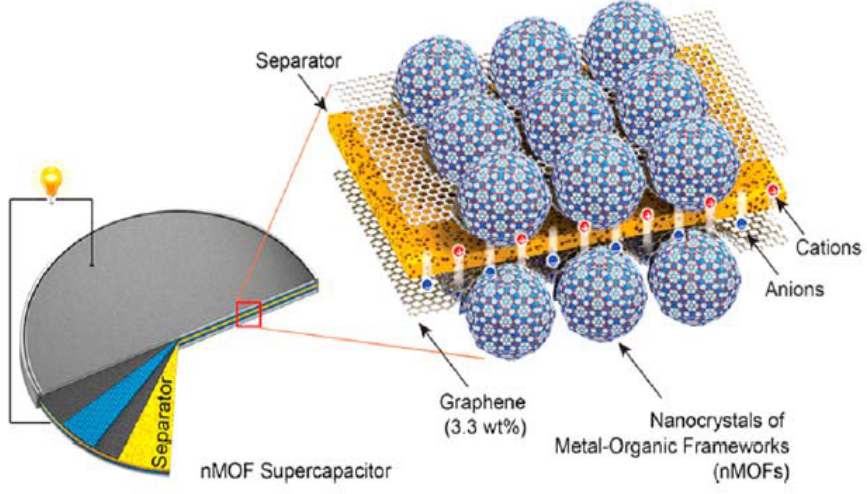
Fig. 6. Construction of nMOF supercapacitors. Adapted from Ref